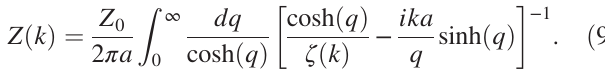
FIG. 4. For flat geometry: the wake of the point charge for copper (red) and aluminum (blue) pipes. The dashed blue line shows the wake for the case when the aluminum pipe is at room temperature (no